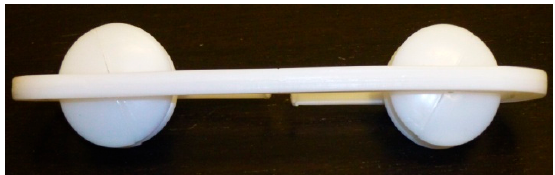
Figure A1. Clothesline roller.